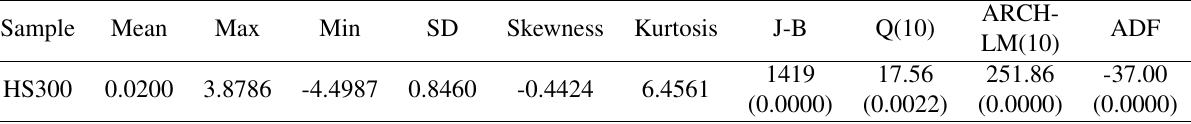
Table 1 Descriptive Statistics of Sample